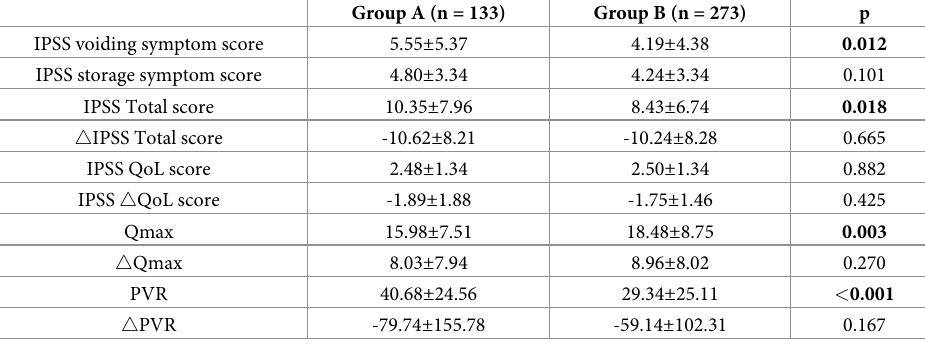
Table 4. Postoperative outcomes at 12months